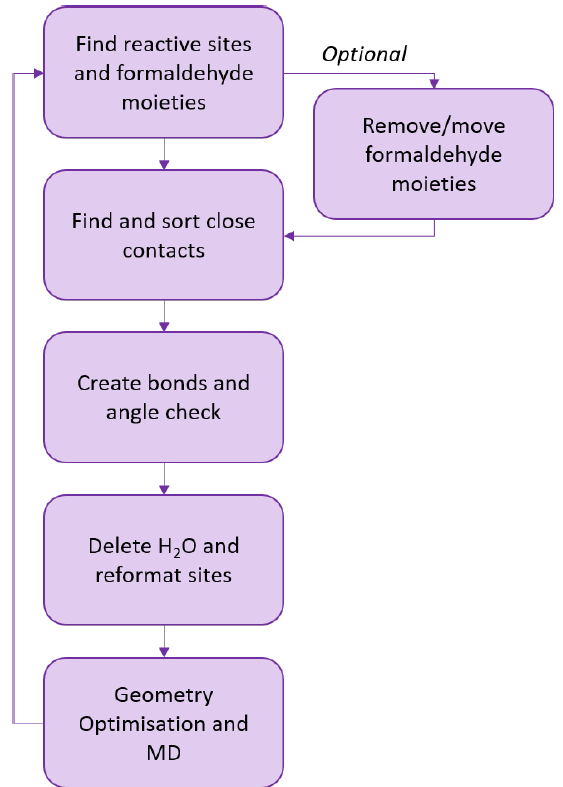
Figure 4. A simplified overview of the script design. The optional formaldehyde moiety deletion/movement methods would be activated when the relative degree of cure between iterations fell too low. This was essential for F:P ratios > 1.5:1, where reactive sites need to be cleared to achieve